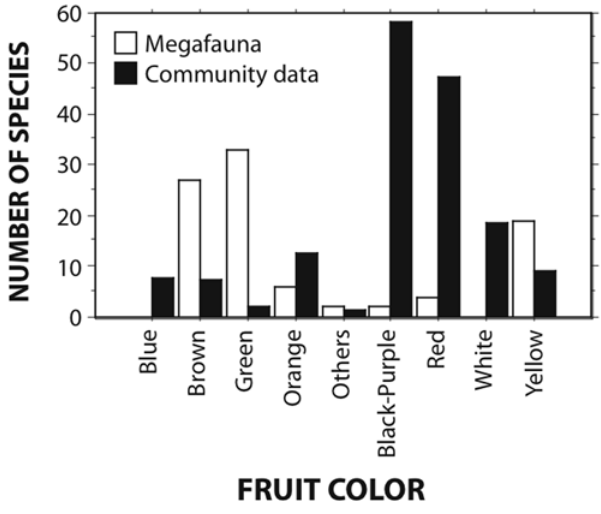
Figure 3. Frequency of megafauna species with different fruit colors (blank bars) compared to the summed frequency in different communities (filled bars). The available data for Manu (Peru), Monteverde (Costa Rica), Florida, Europe [118] New Zealand [124], and Brazilian Myrtaceae [125] have been pooled to characterize the color distribution pattern in extant